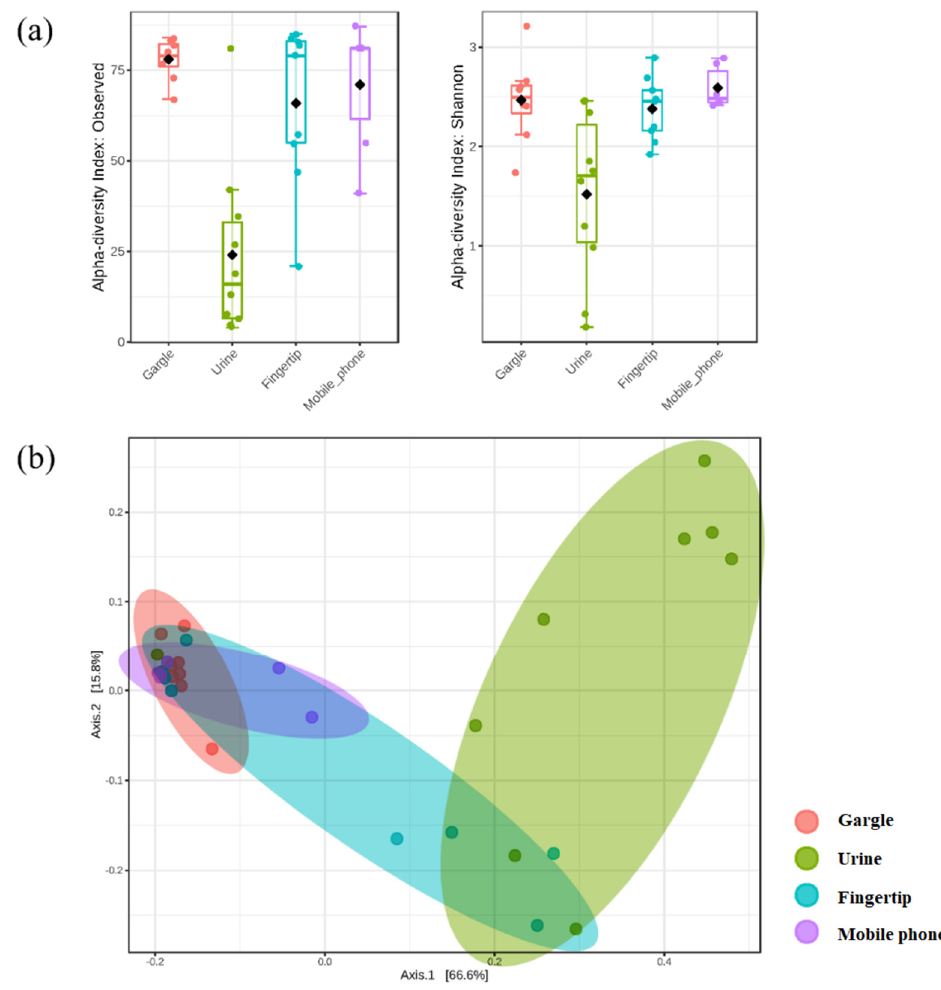
Figure 2. Results of α and β diversity, which reveal the total strain abundance and type ( a ) α diversity with Observed (left) and Shannon (right) index and ( b ) β diversity with Jensen-Shannon divergence index.